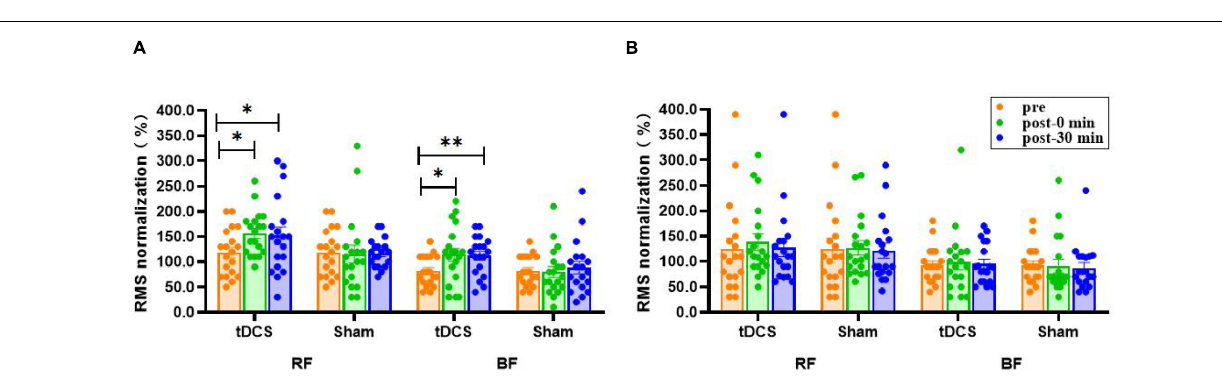
FIGURE 5 | Effects of tDCS on RMS amplitudes (%) of left (A) and right (B) rectus femoris and biceps femoris sEMG. pre: prestimulation, post-0 min: 0 min after stimulation, post-30 min: 30 min after stimulation; RF: rectus femoris, BF: biceps femoris. Data are presented as mean ± SEM. Asterisks ( ∗ ) indicate statistically significant difference compared to prestimulation ( ∗ P < 0.05, ∗∗ P <